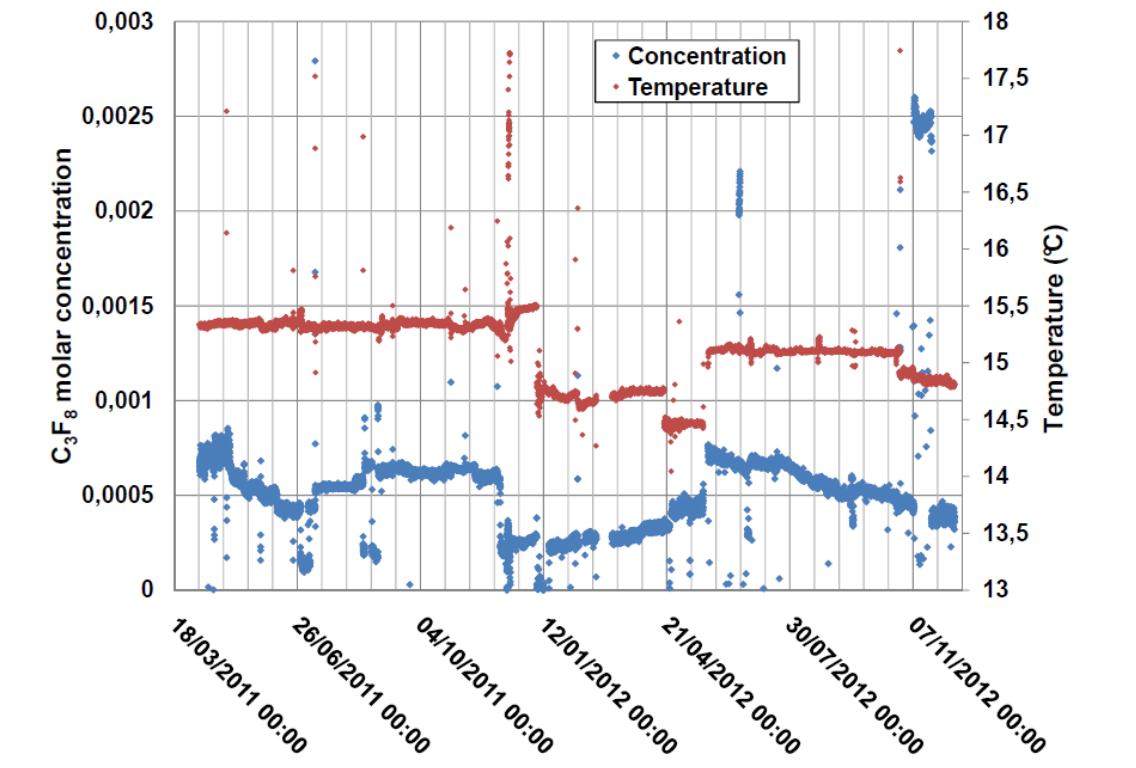
Figure 11. This plot of the long duration (>18 month) log of C the N environmental gas surrounding the ATLAS Pixel Detector confirms suspected leaks 2 and establishes the leak rate into the detector volume